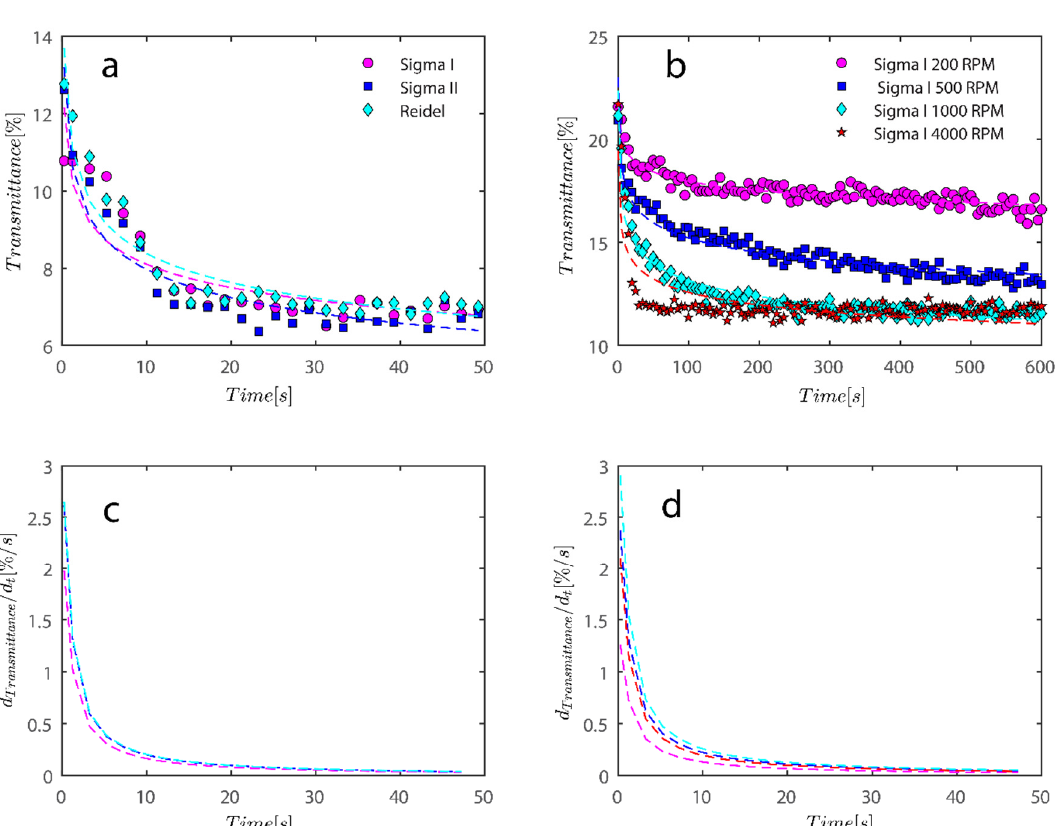
Figure 9. For the data shown in Figures 5 and 6, an analysis of the sediment bed at a height of 130 mm as a function of time was performed. ( a ) The reduction in transmission intensity for the Riedel, Sigma I, and Sigma II samples at the cell’s roughly 130 mm end as a function of time at rotational speeds of 200, 500, 1000, and 4000 rpms; ( b ) reduction in transmission intensity for Sigma I samples with time at rotational speeds of 200, 500, 1000, and 4000 rpms at a point 130 mm or so from the cell’s end; ( c ) the power law’s derivative fits in Figure 8a, and related information is shown in Table 2. The data that correspond to ( d ) derivative of the power law are shown in Table 2 along with Figure 8b. Table 2. Power law fits parameters associated with Figures 7–9.